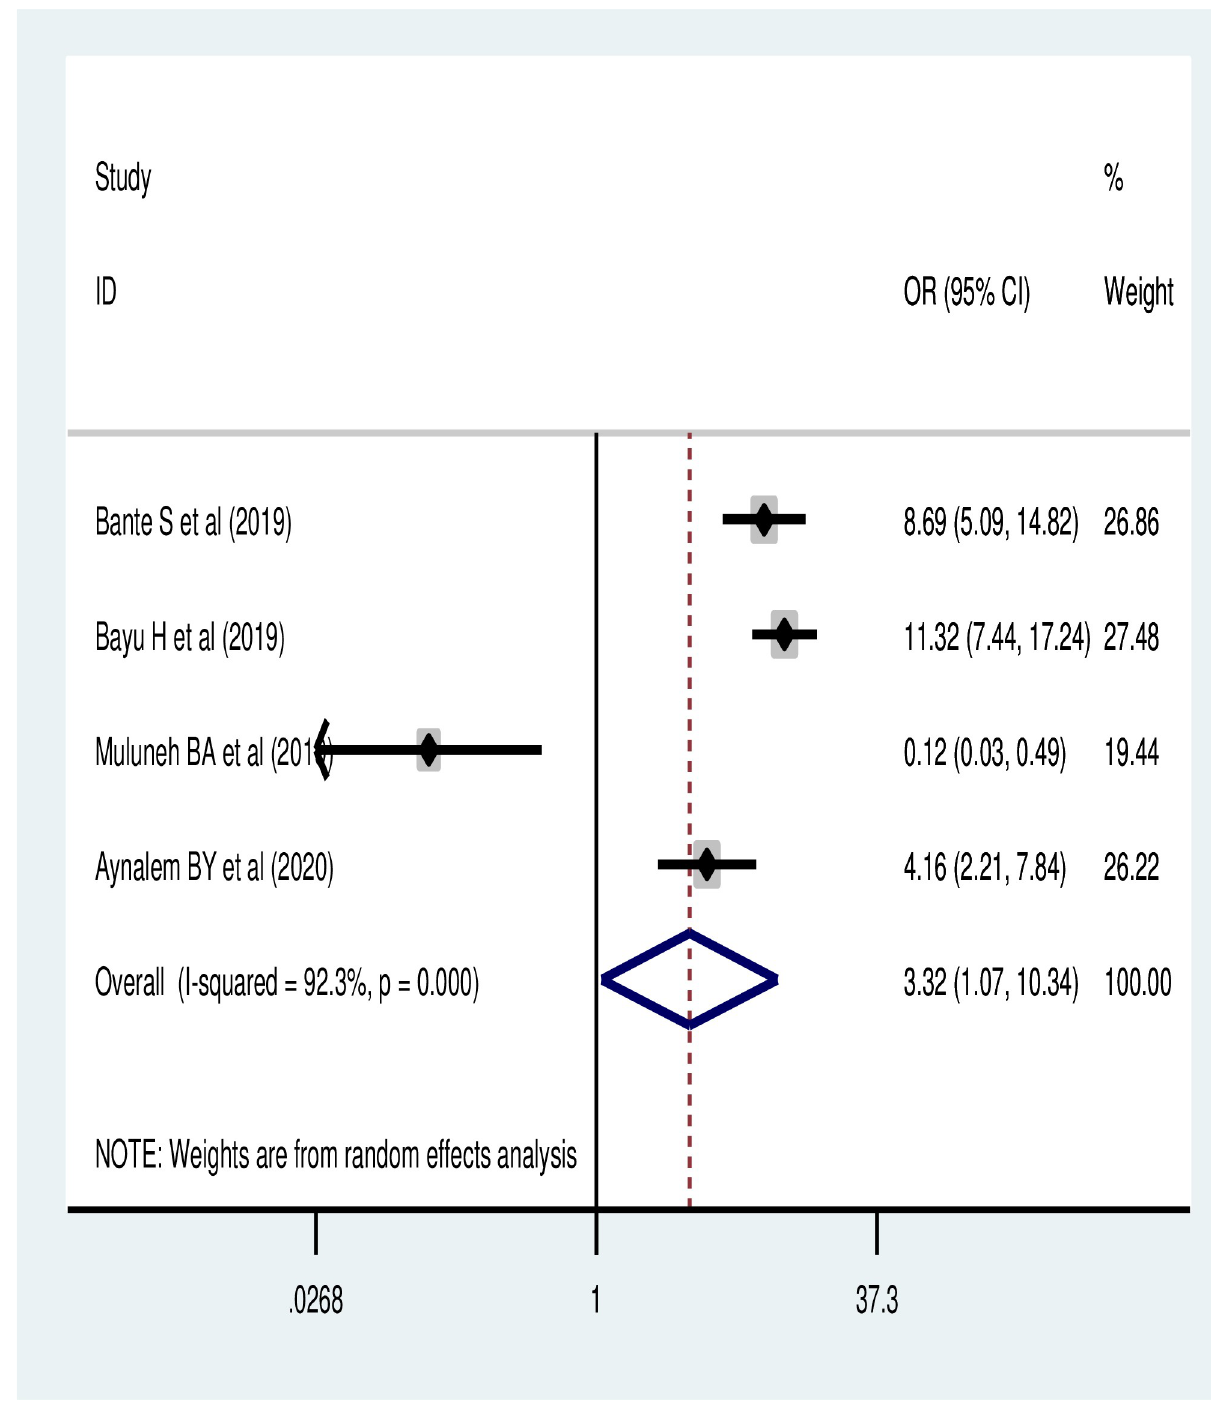
Fig 8. Association of history of sexual transmitted infection with cervical cancer screening